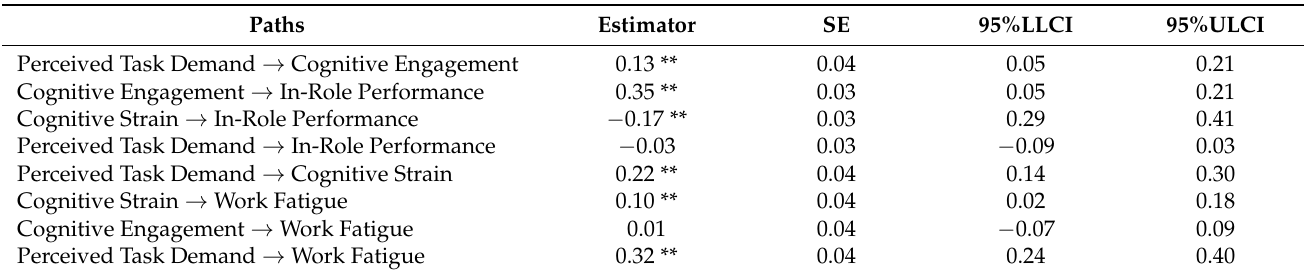
Table 3. Results of multilevel structural equation model.